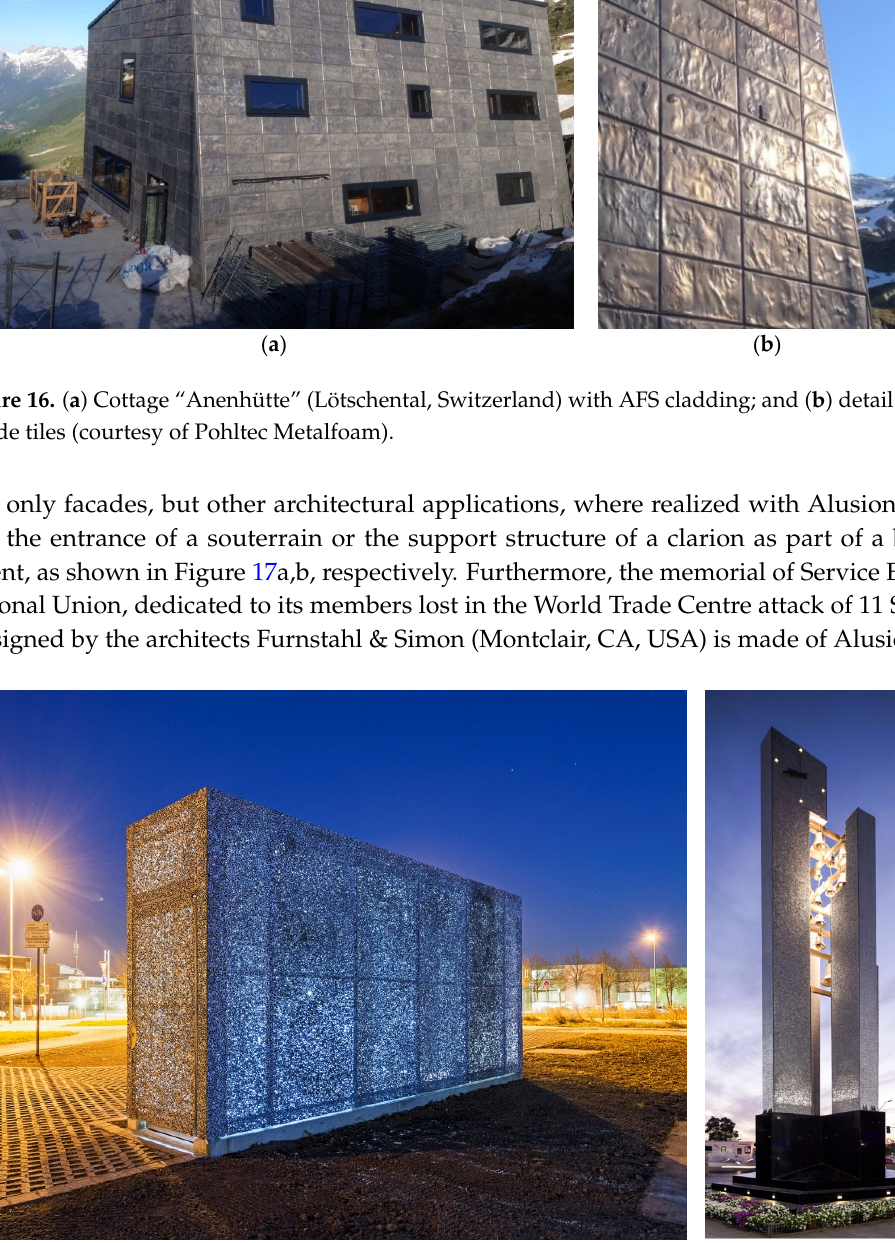
Figure 17. Translucent entrance of a souterrain and bell tower monument made of Alusion foam (courtesy of Alusion).